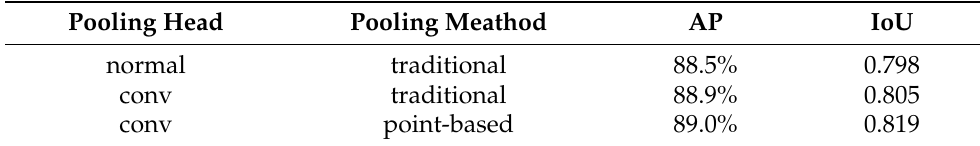
Table 3. Quantitative evaluation of the boundary regression